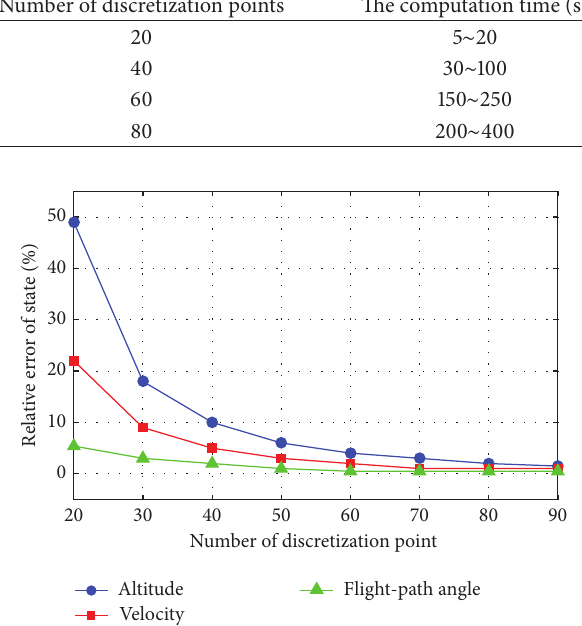
Figure 1: Example of relative errors between approximated and real trajectory of 25 min flight time using